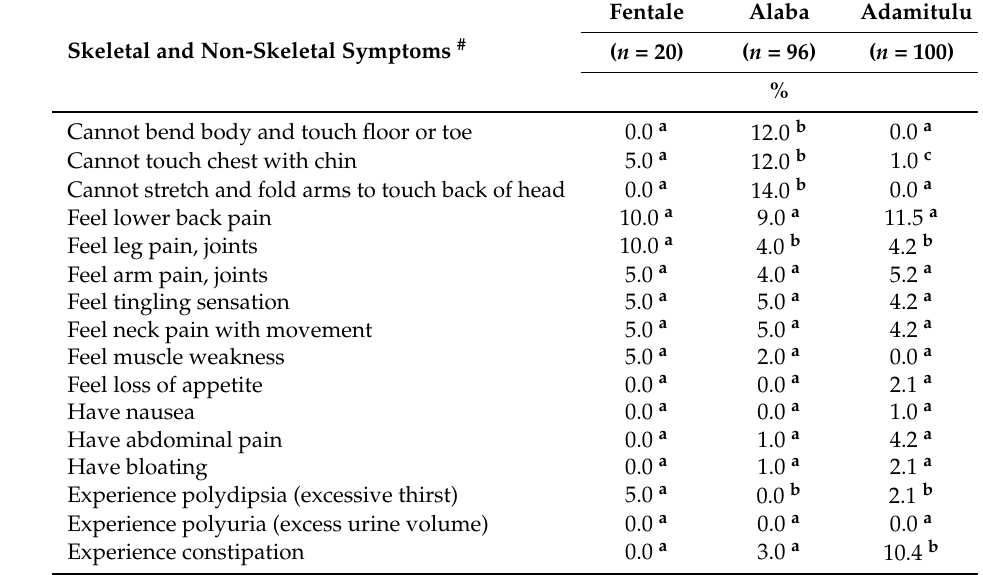
Table 5. Prevalence of skeletal and non-skeletal symptoms of school age